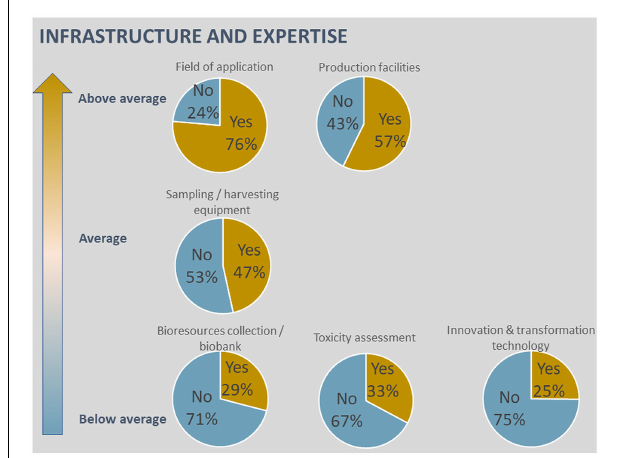
FIGURE 1 | Assessment of existing tools and infrastructures and expertise in the marine biotechnology inquiry. Based on the responses we categorized the existing expertise and infrastructures into: below average (where < 50% of respondents have specific expertise), average (where around 50% of respondents have specific expertise), and above average (with > 50% of respondents having specific expertise and